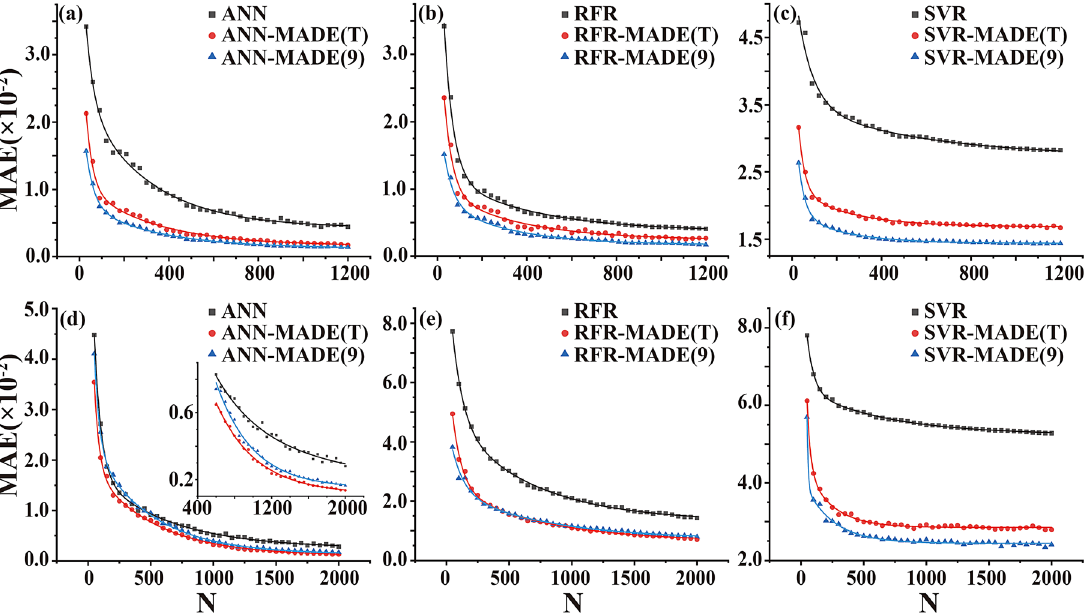
Figure6: ComparisonofMAEamongdifferentMLalgorithmsandtheMADEmodelscoupledwiththesealgorithms,incasesofvariousnumbers of training